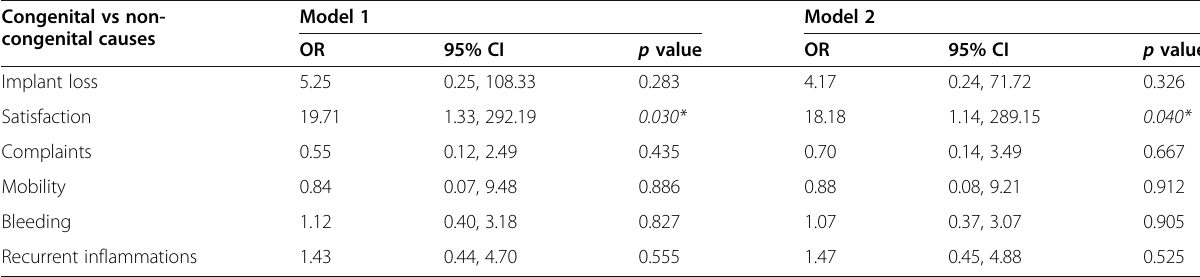
Table 3 Association between the cause of missing teeth and implants outcomes Congenital vs non- congenital